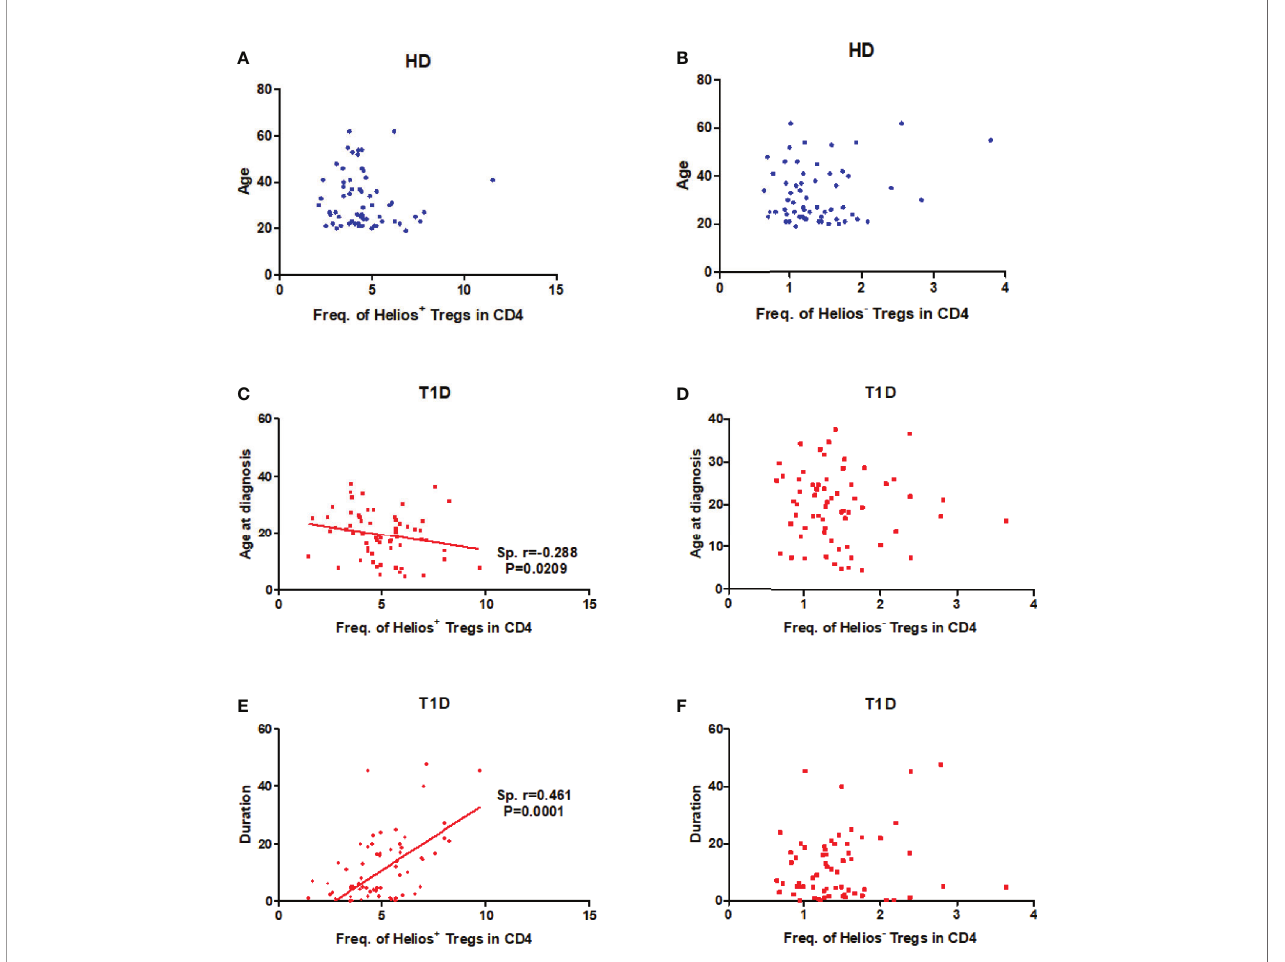
FIGURE 2 | Correlation between frequency of Helios + or Helios − Tregs in CD4 T cells and age at time of blood donation and T1D disease status. (A, B) Correlation between frequency of Helios + or Helios − Tregs in CD4 T cells and age at time of blood donation in healthy controls respectively. (C, D) Correlation between frequency of Helios + or Helios − Tregs in CD4 T cells and age at T1D diagnosis in T1D individuals respectively. (E, F) Correlation between frequency of Helios + or Helios − Tregs in CD4 T cells and T1D duration in T1D individuals respectively. HD, healthy controls. The results were from 68 healthy controls and 68 autoantibody- positive T1D individuals. Samples from T1D individuals and healthy controls were randomly divided to each independent experiment. One biological sample (from the same healthy donor and drawn at the same time) was performed as control for the experimental reproducibility. Spearman correlation was performed for these correlations. A p value below 0.05 indicates a signi fi cant difference between